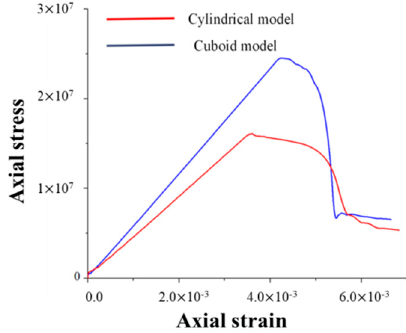
Figure 8. Stress–strain curves for different shape models.